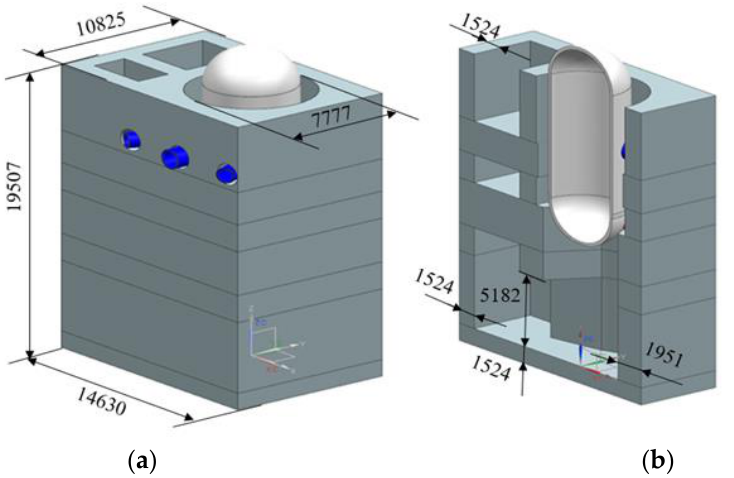
Figure 1. Modeling of the walls of the reactor cavity. ( a ) The overall shape of the reactor cavity. ( b ) The interior of the reactor